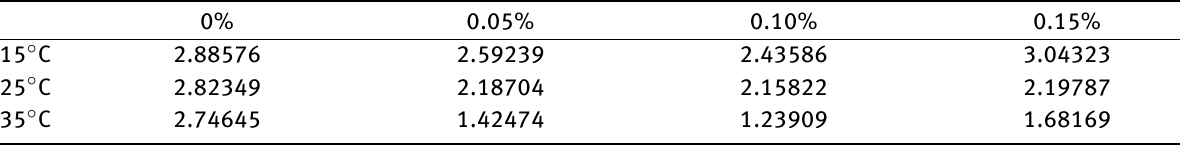
Table 6: ZSV of energetic materials contenting graphene at different temperature ( × 10 6 Pa · s, 1mL/g).